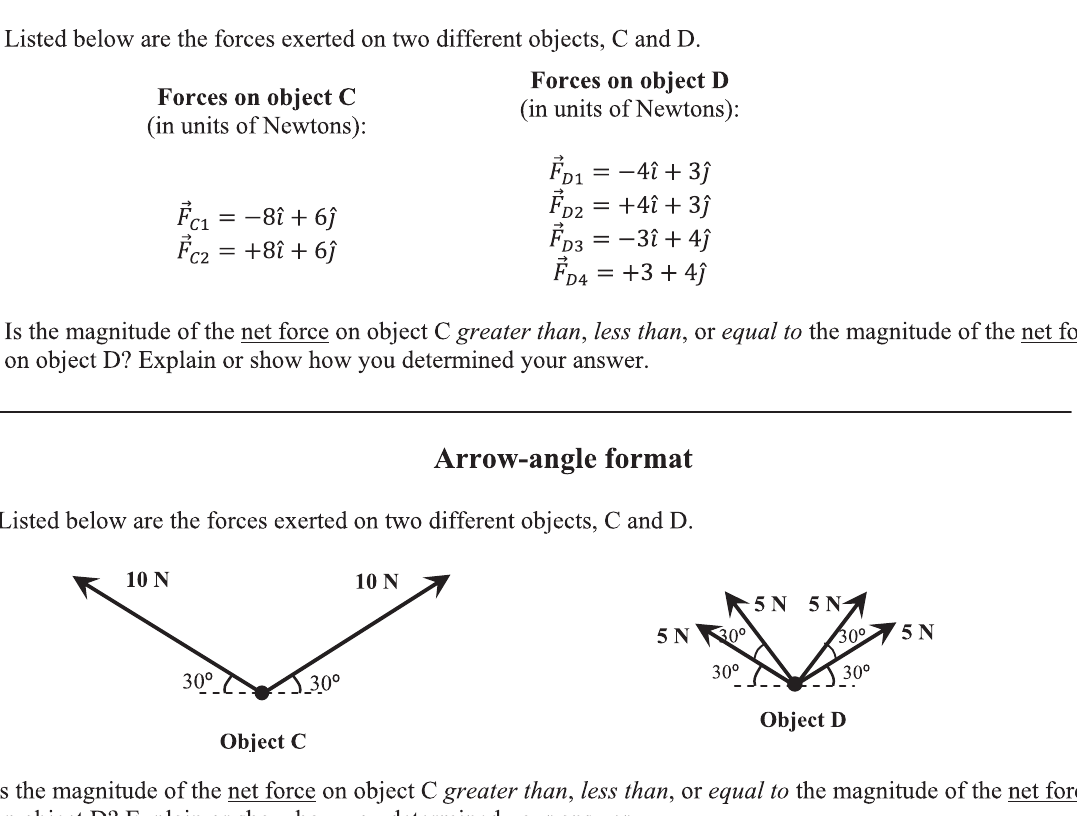
FIG. 6. Examples of two-dimensional physics context questions in arrow grid, arrow angle, and ijk